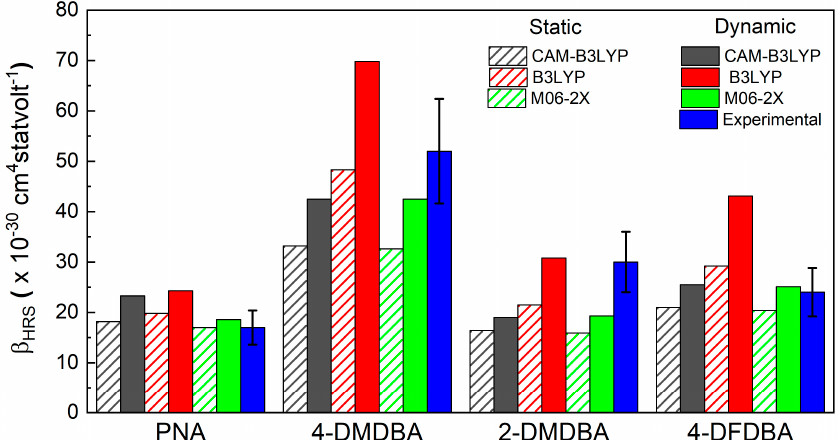
Figure 4. Experimental and theoretical values of the first molecular hyperpolarizability of all DBA derivatives studied, including the reference compound (PNA), in dichloromethane medium.